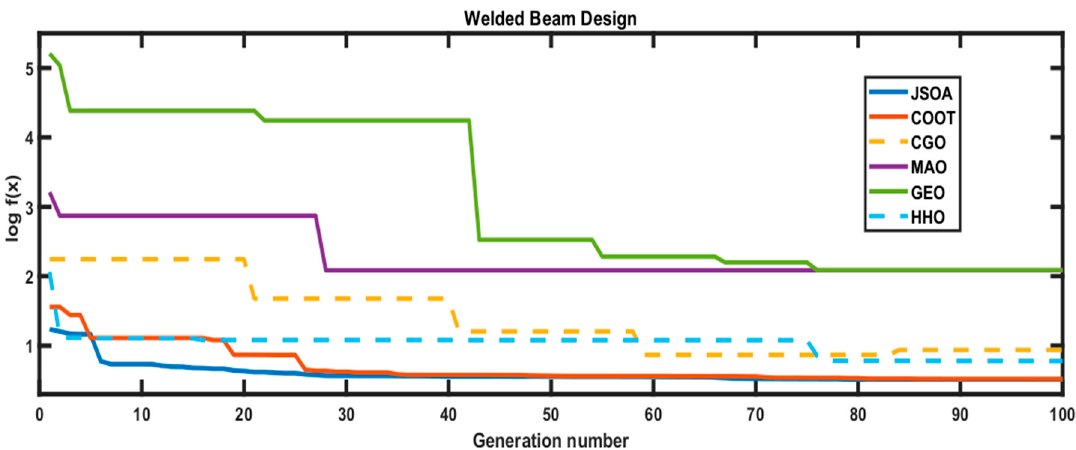
Figure 14. Convergence graph of Welded Beam Design. The dotted line represents an infeasible solution shown by an algorithm.